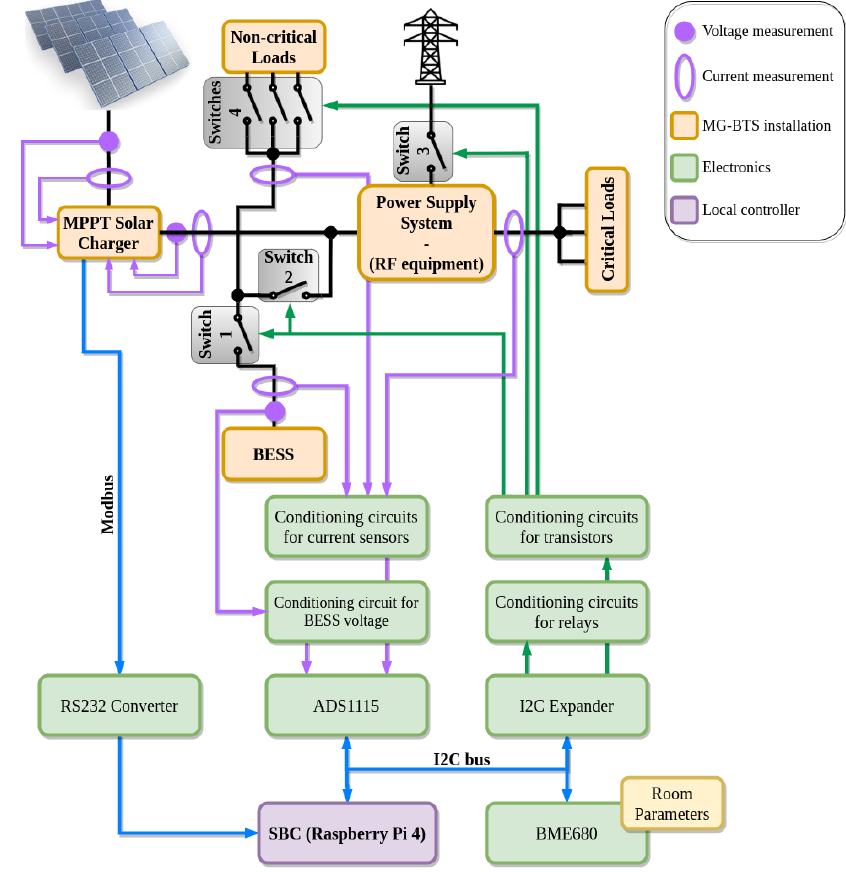
Figure 3. Measurement and control electronics of the MG-based BTS.